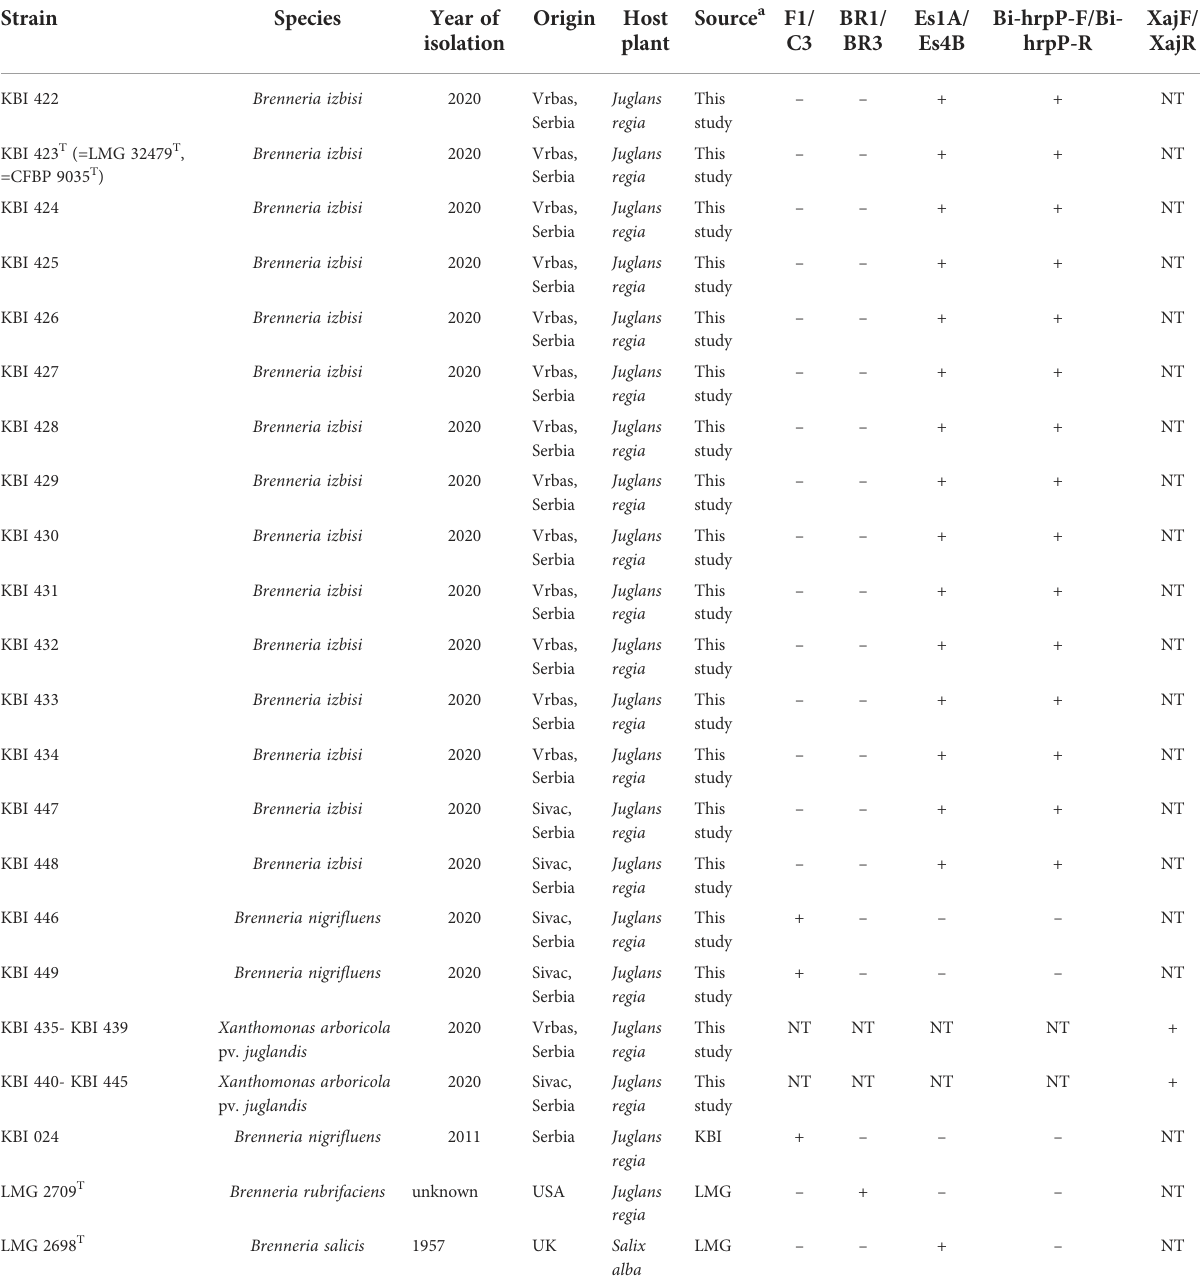
TABLE 1 Bacterial strains used in this study and results of PCR